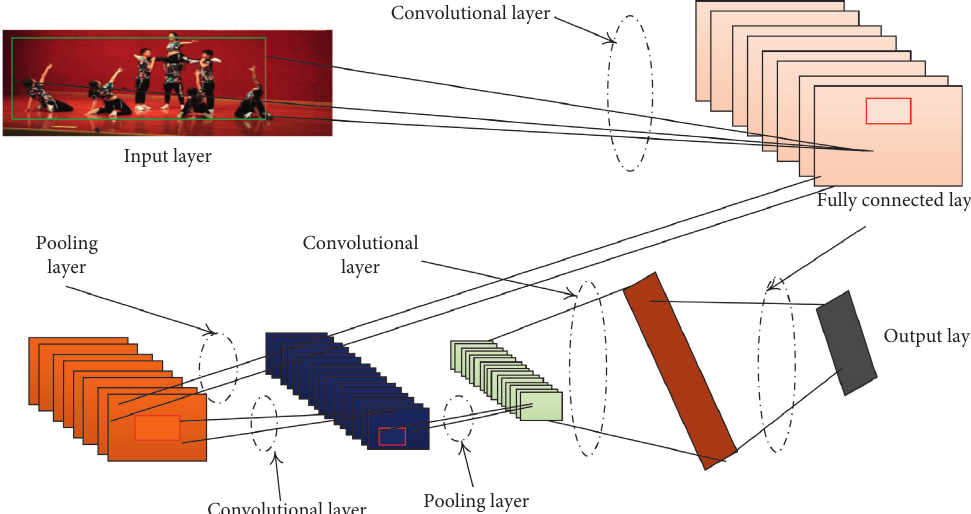
Figure 2: Model diagram of 3D visual image recognition of aerobics based on